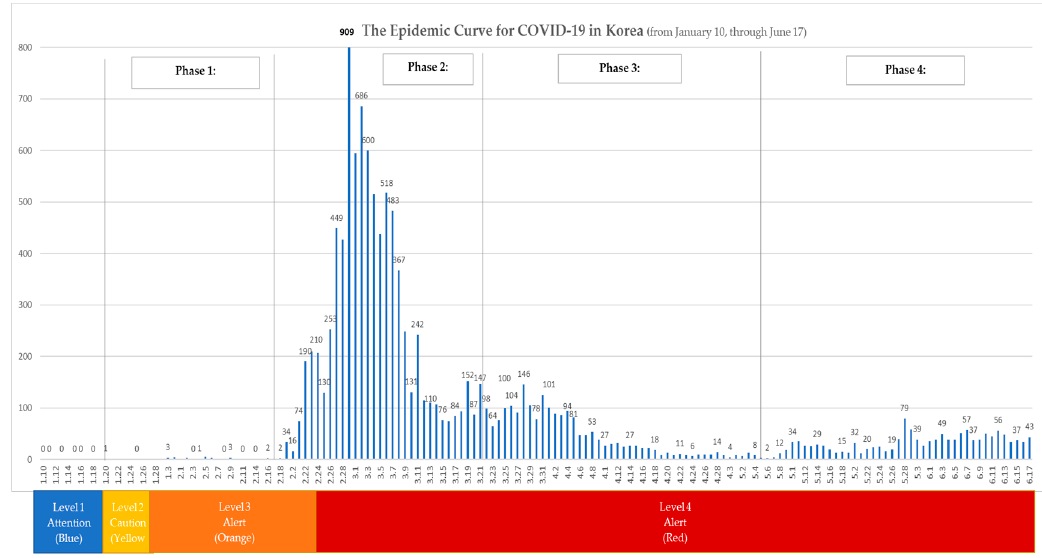
Figure 11. The Epidemic Curve for COVID-19 in Korea.